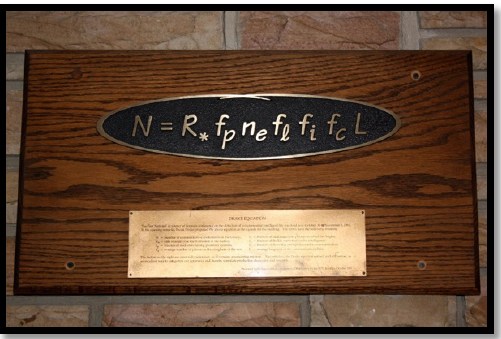
Fig. 3 . The Drake Equation plaque mounted above the fireplace in the conference room/library of the residence hall of the National Radio Astronomy Observatory in Green Bank, West Virginia. It depicts the Drake’s equation commemorating the first SETI